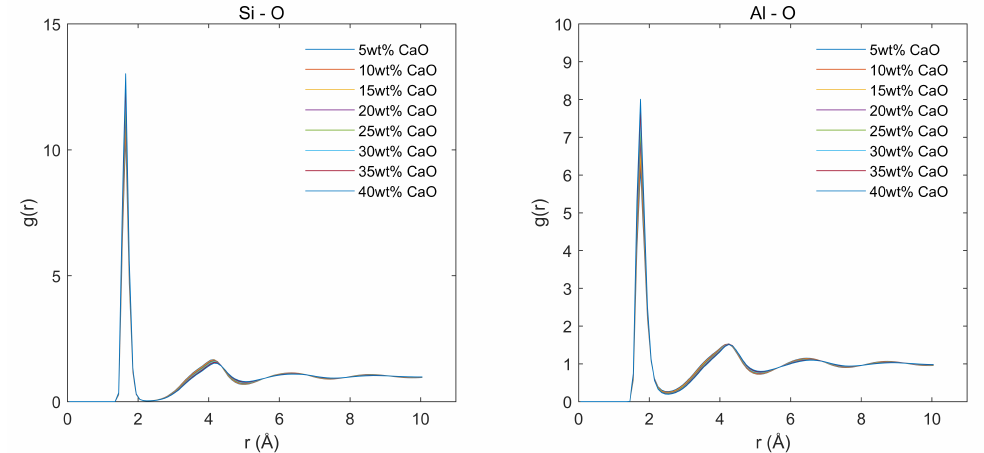
Figure 6. Radial pair distribution functions g ( r ) of Si–O and Al–O for CaO–Al 2 O 3 –SiO 2 systems with different CaO contents at 2000 K.